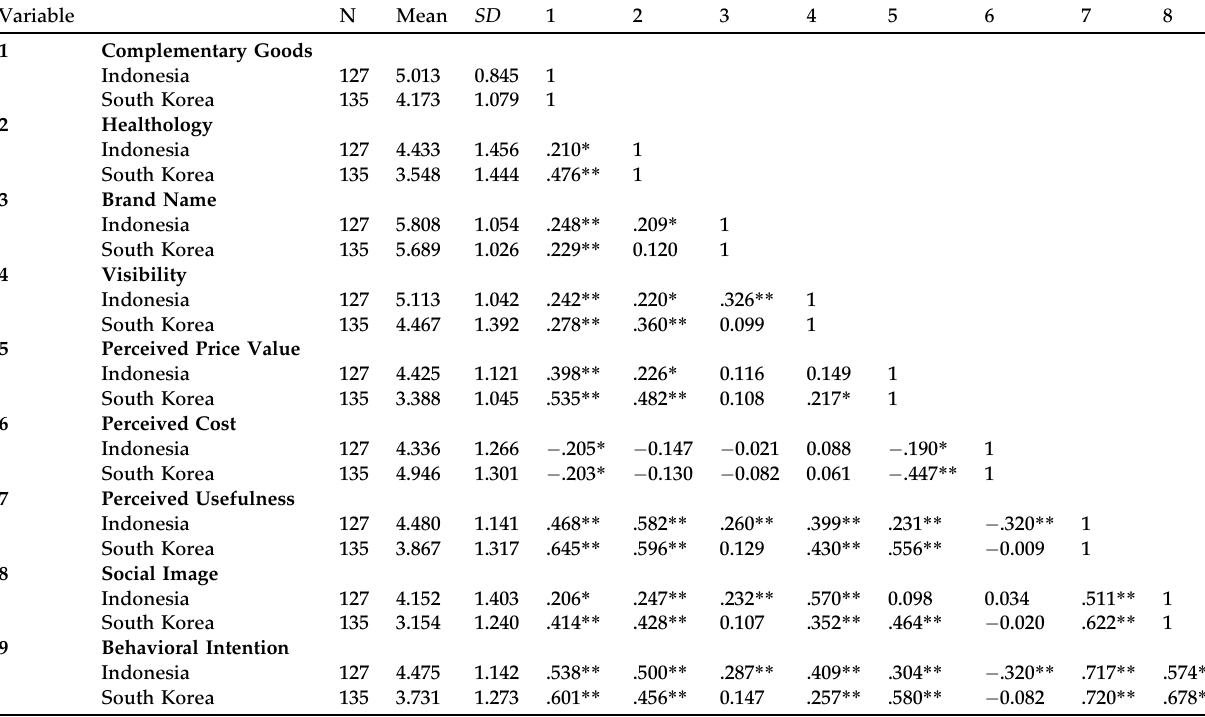
Table 4. Correlation matrix. Variable Complementary Goods Indonesia